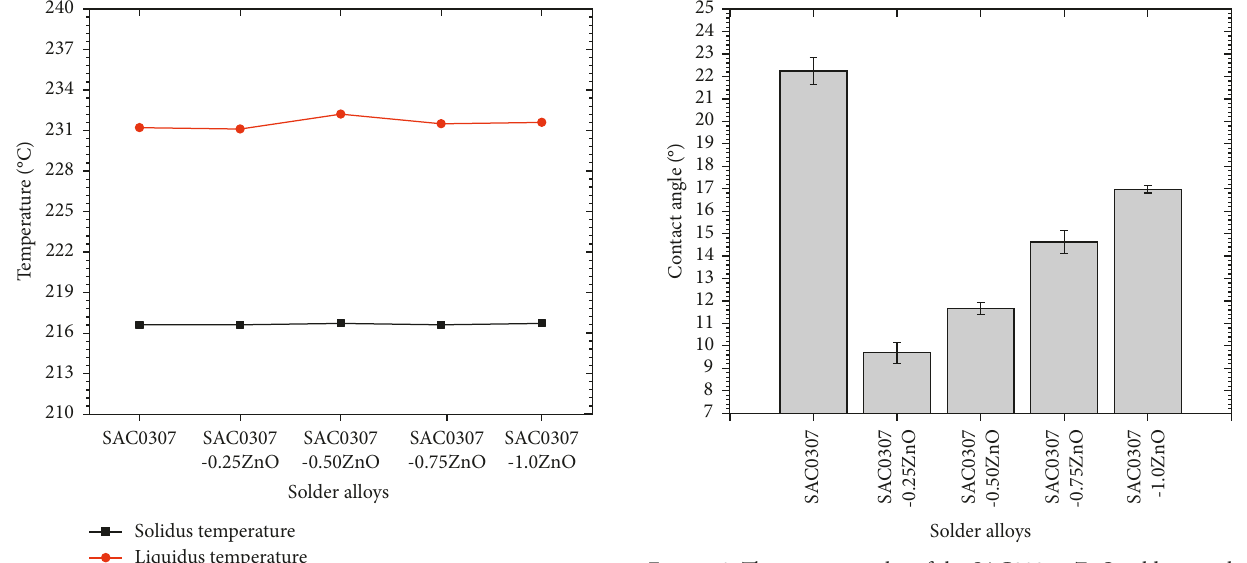
Figure 3: The contact angles of the SAC0307-xZnO solders on the copper substrate.